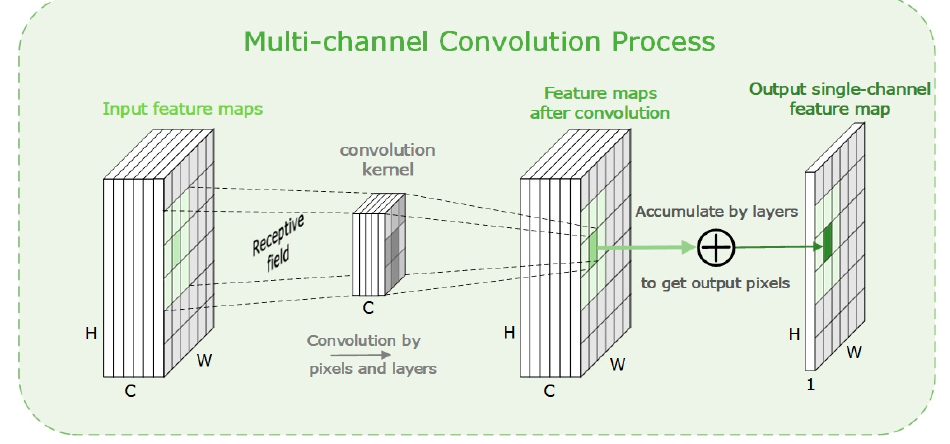
Figure 1. A multi-channel convolution process where a single convolutional kernel convolves with the corresponding feature maps, and the individual layer pixel positions are added to produce an output single-channel feature map.